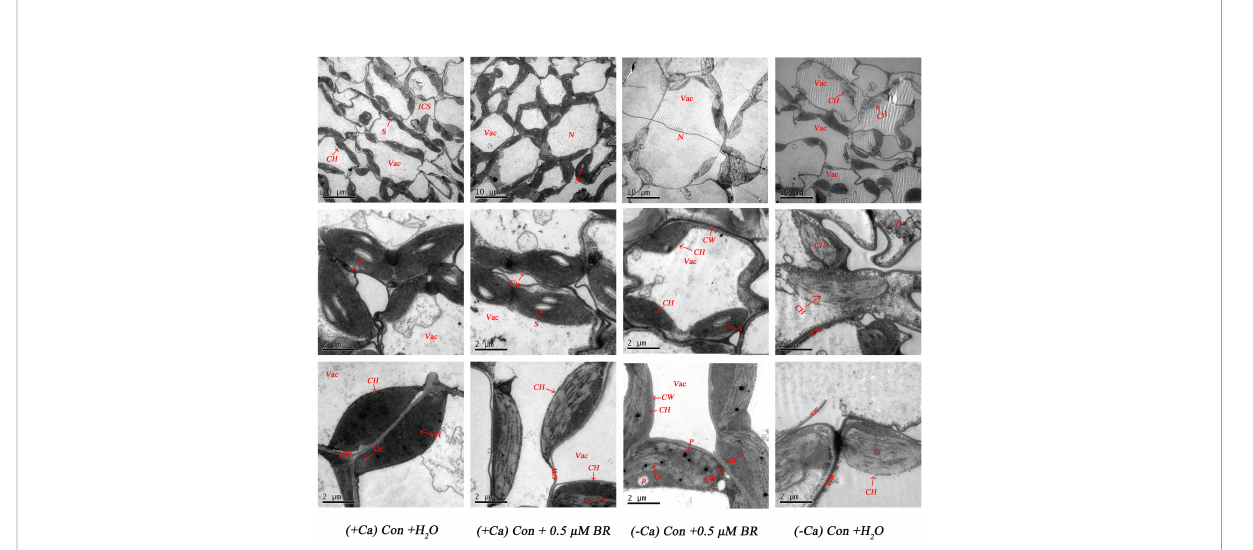
FIGURE 4 Effect of exogenous BRs on mesophyll cells ultrastructure of mini Chinese cabbage. CW, cell wall; Vac, vacuole; ICS, intercellular space; S, starch granule; ch, chloroplast; N, cell; P, plastid globule; OG, osmiophilic granule; ST, stromal lamella. The scale of chloroplasts was 10 m m and 2 m